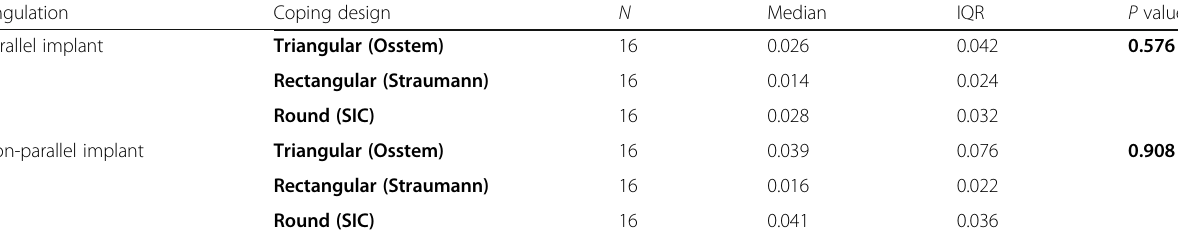
Table 3 Effect of implant angulation on accuracy in the closed tray impression coping design in the horizontal measurements Angulation